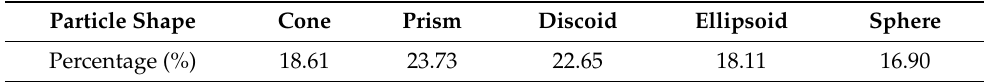
Table 3. Model parameters for different fill